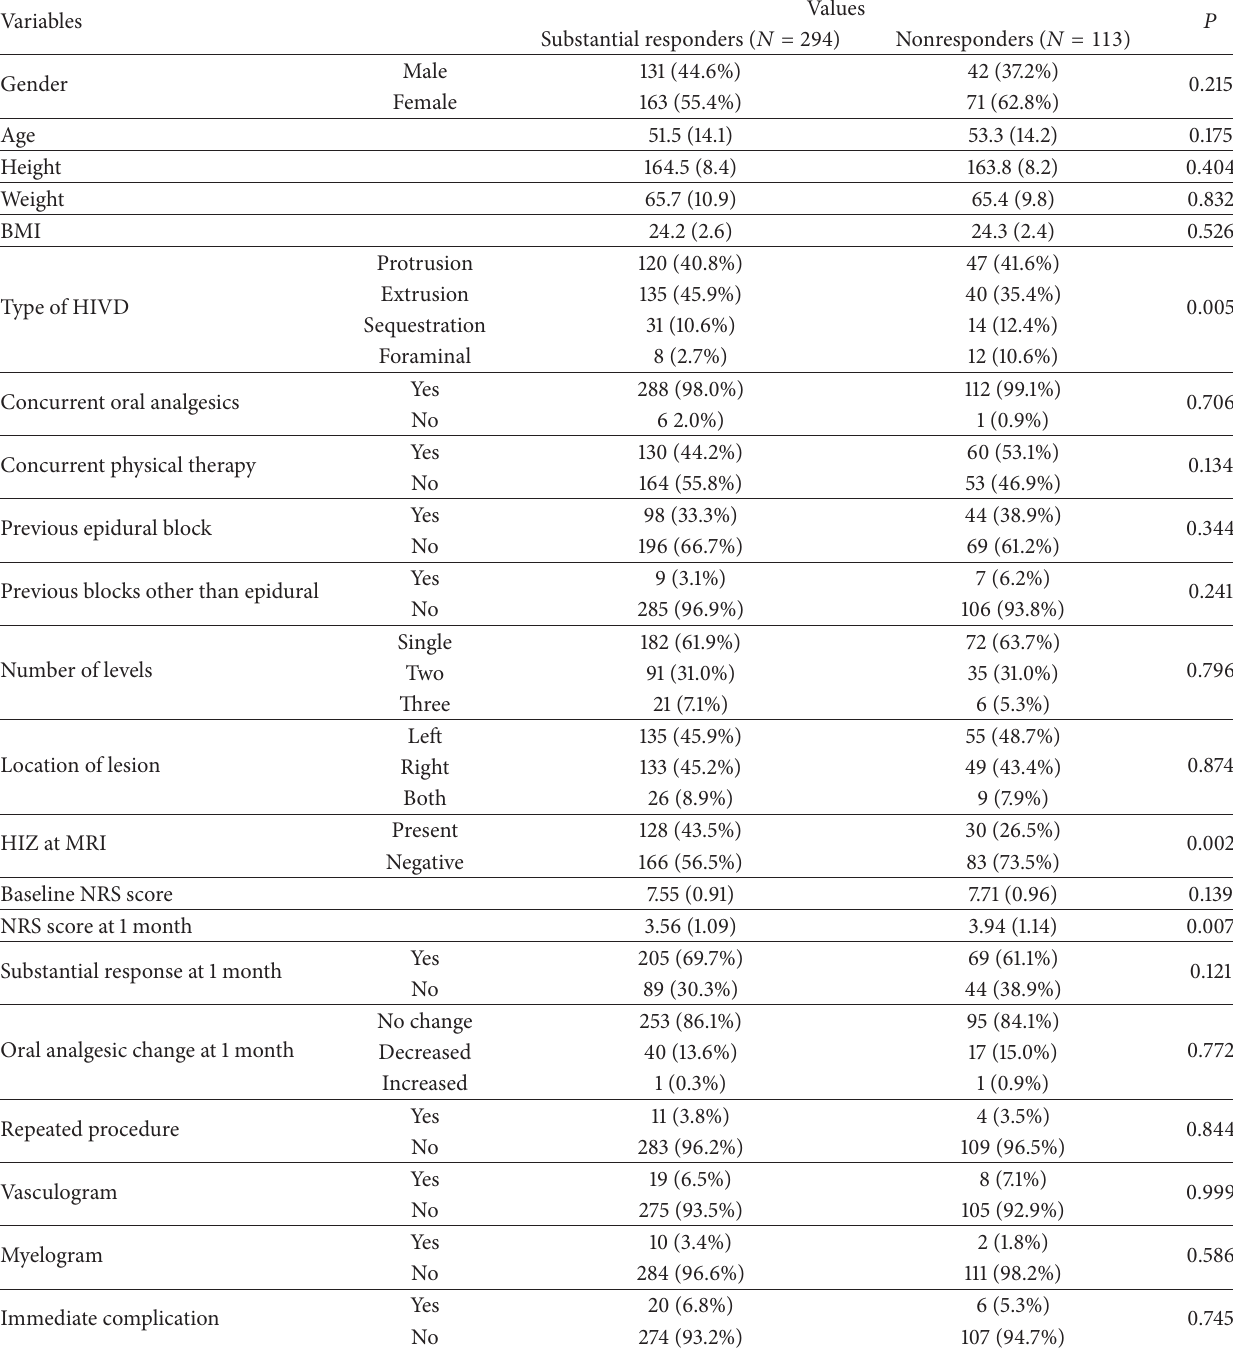
Table 2: Results for substantial responders compared to nonresponders 12 months after percutaneous epidural adhesiolysis, as classified by demographic and clinical